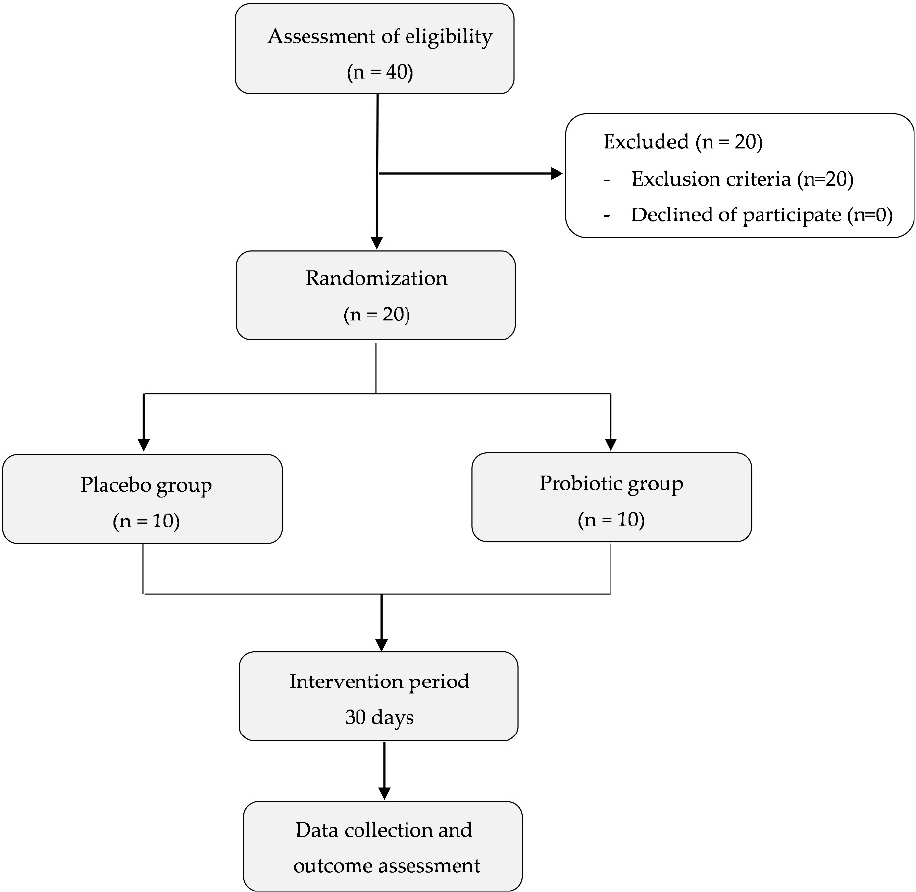
Figure 1. The study flow diagram and enrollment.